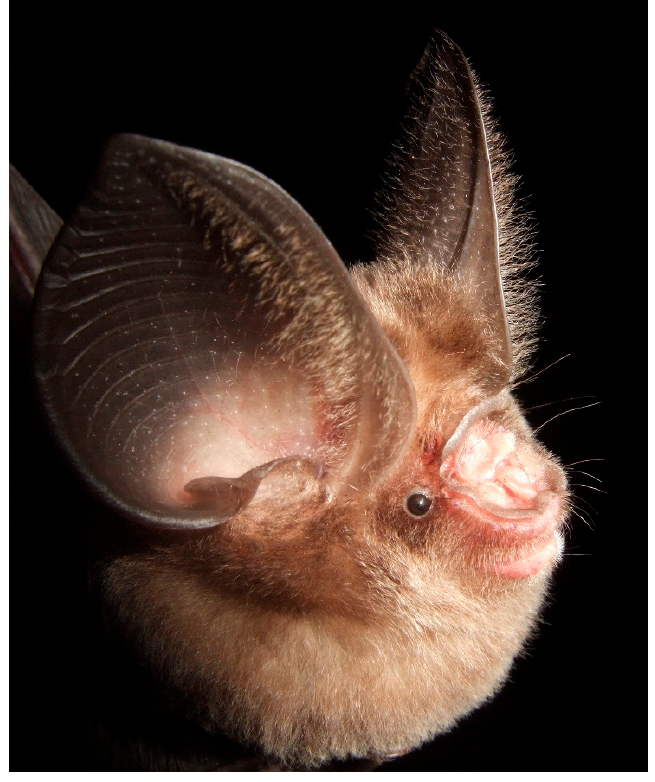
Figure 15. Hipposideros khaokhouayensis , adult male. Photograph by Vu Dinh